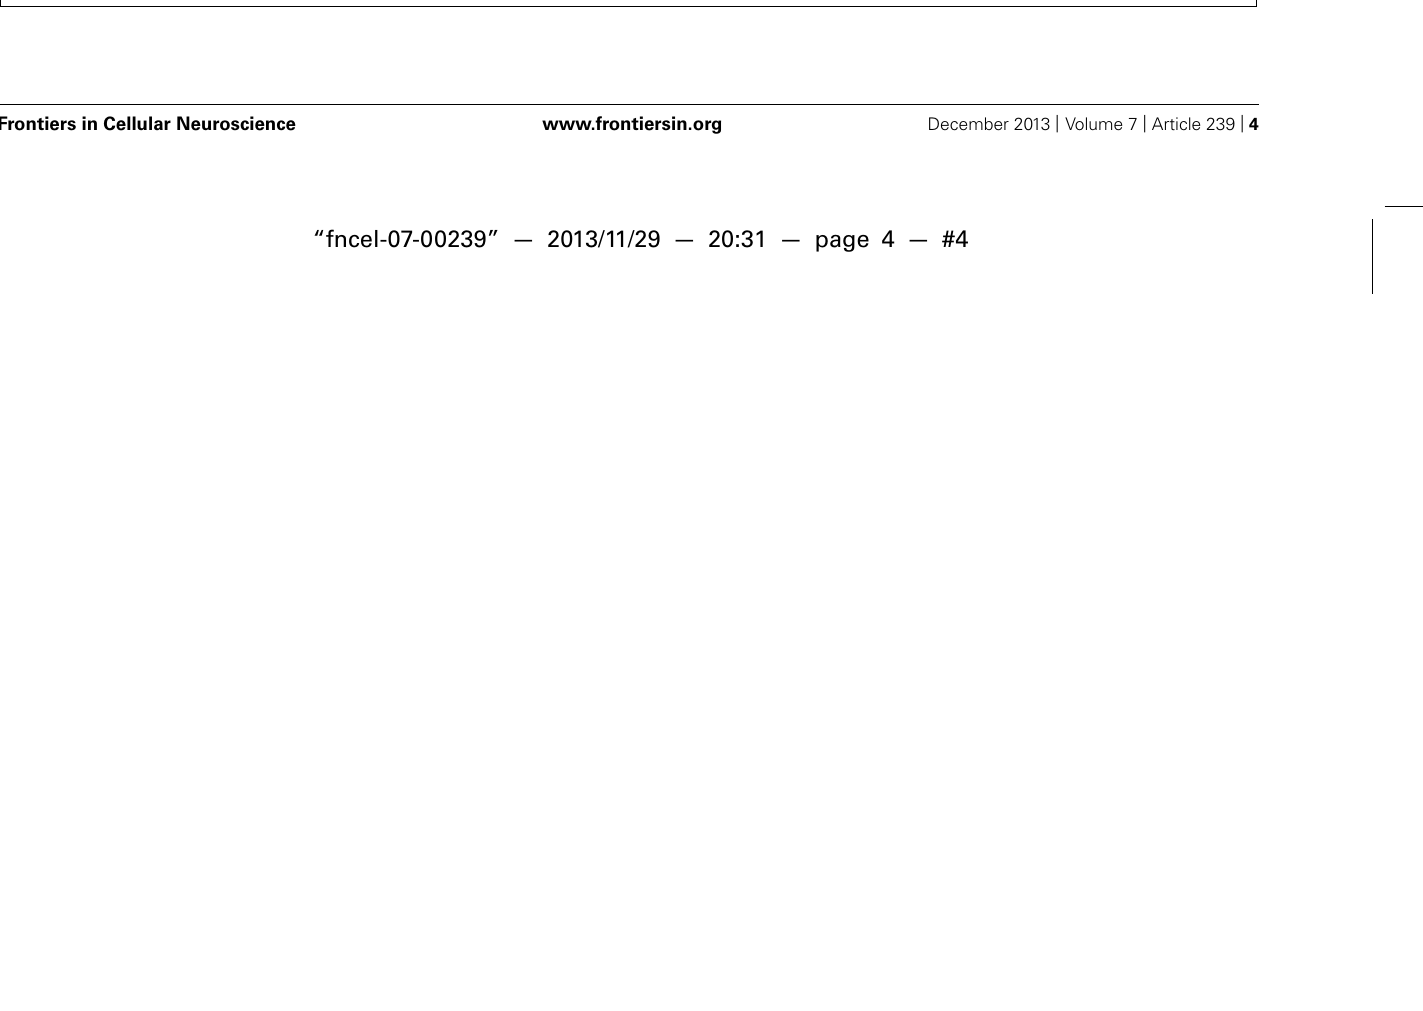
∗∗ p < 0.001, ∗∗∗ p < 0.001, ANOVA) as well as a morphological evaluation of the adhesion. (B) Culture dishes were coated with the indicated concentrations of PLL for 24 h. When indicated, gelatin was added for 30 min. Cells were allowed to adhere for 36 h, and differentiated for additional 24 h and analyzed by phase contrast microscopy. A total of 60,000 cells were seeded in every condition, except for the lowest panel pictures, where the number was diminished to 40,000 cells. Bar, 50 μ